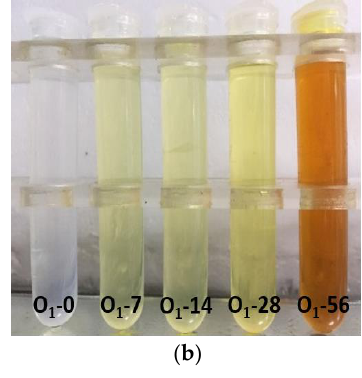
Figure 5. ( a ) Color of O 0 ; ( b ) Color of O 1 .